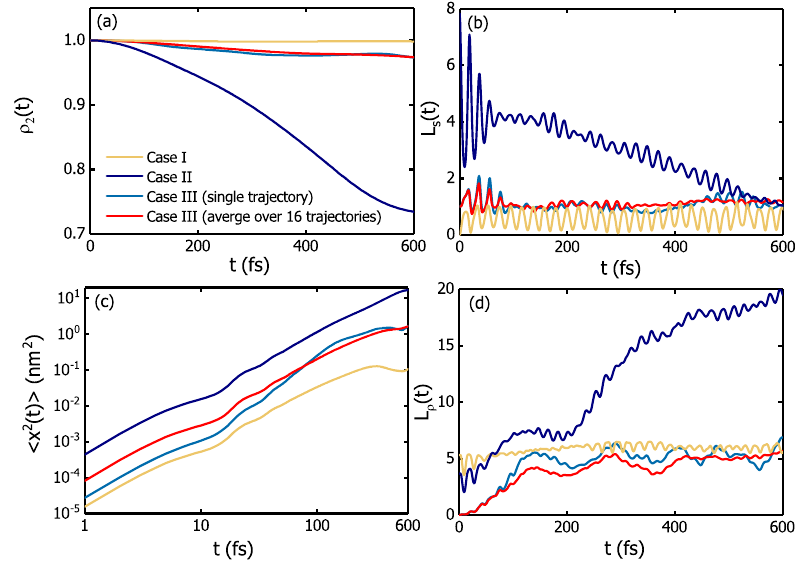
Figure 4. The exciton population on the central complex ( a ), the superradiance enhancement factor ( b ), the MSD ( c ), and the coherence size ( d ) for the exciton diffusion in a B850 chain with three B850 complexes. The calculations are performed with three initial excitation conditions, i.e., the lowest (Case I) and the second lowest (Case II) exciton states, and an individual pigment (Case III) of the central complex. For comparison, the results from a single trajectory (blue curves) of Case III are shown with the averaged results over 16 trajectories (red